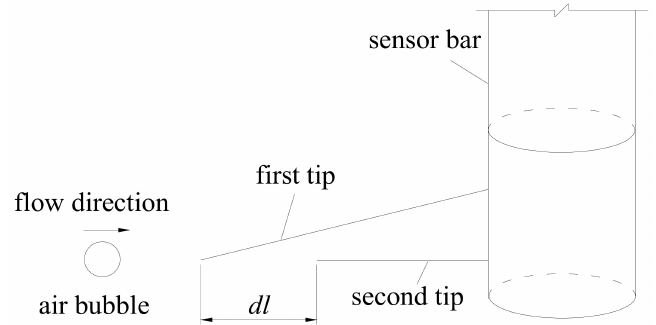
Figure 2. Sketch needle